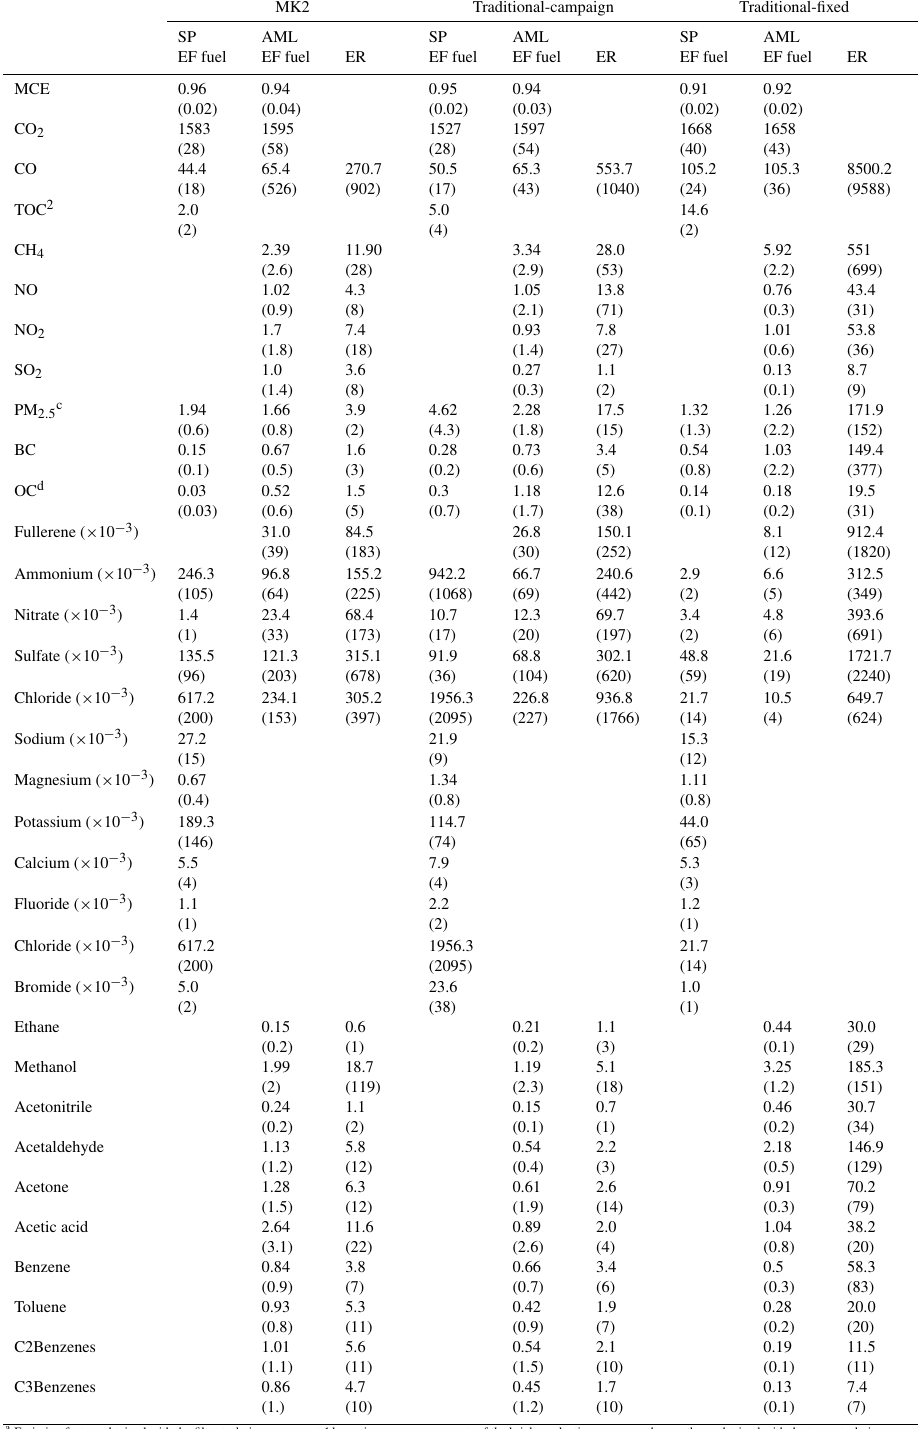
Table 2. Average modified combustion efficiency (MCE), fuel-based emission factors EF (gkg − 1 fuel), and emission rates ER (gmin − 1 ) obtained with the sampling probe (SP) and tracer ratio (AML) techniques.